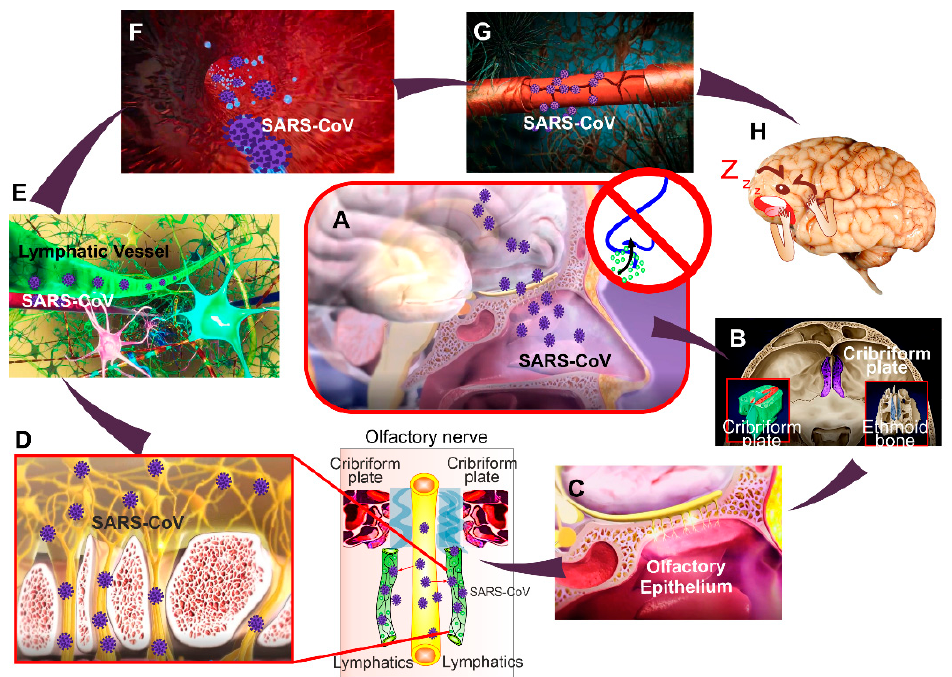
Figure 4. Brain mechanisms of COVID-19-sleep disorders: ( A – C ) The one hypothesis explains that the SARS-CoV-2 infiltrates the brain ( A ), possibly from the cribriform plate ( B ) and the olfactory epithelium ( C ). The cribriform plate ( B ) is a center of the lymphatic pathway of metabolic clearance and is a connective bridge between the cerebral spinal fluid and the cervical lymphatic system) [138–145]; ( D , E ) the virus can enter into the brain through the anatomical connection between the meningeal lymphatic vessels and the lymphatic vessels localized along the olfactory nerve [141]. The lymphatic window into the brain is considered in [146–148]; ( F – H ) The SARS-CoV-2 via the ACE2 receptor on the endothelial cells of the lymphatic vessels [149] can enter into the brain tissues inducing cytokine storm ( F ) and endothelial inflammation that alters the BBB integrity ( G ) facilitating COVID-19-related sleep disorders ( H ). SARS-CoV-2 also affects the olfactory centers (olfactory bulb and cortex), thereby reducing smell sensations [150–156].